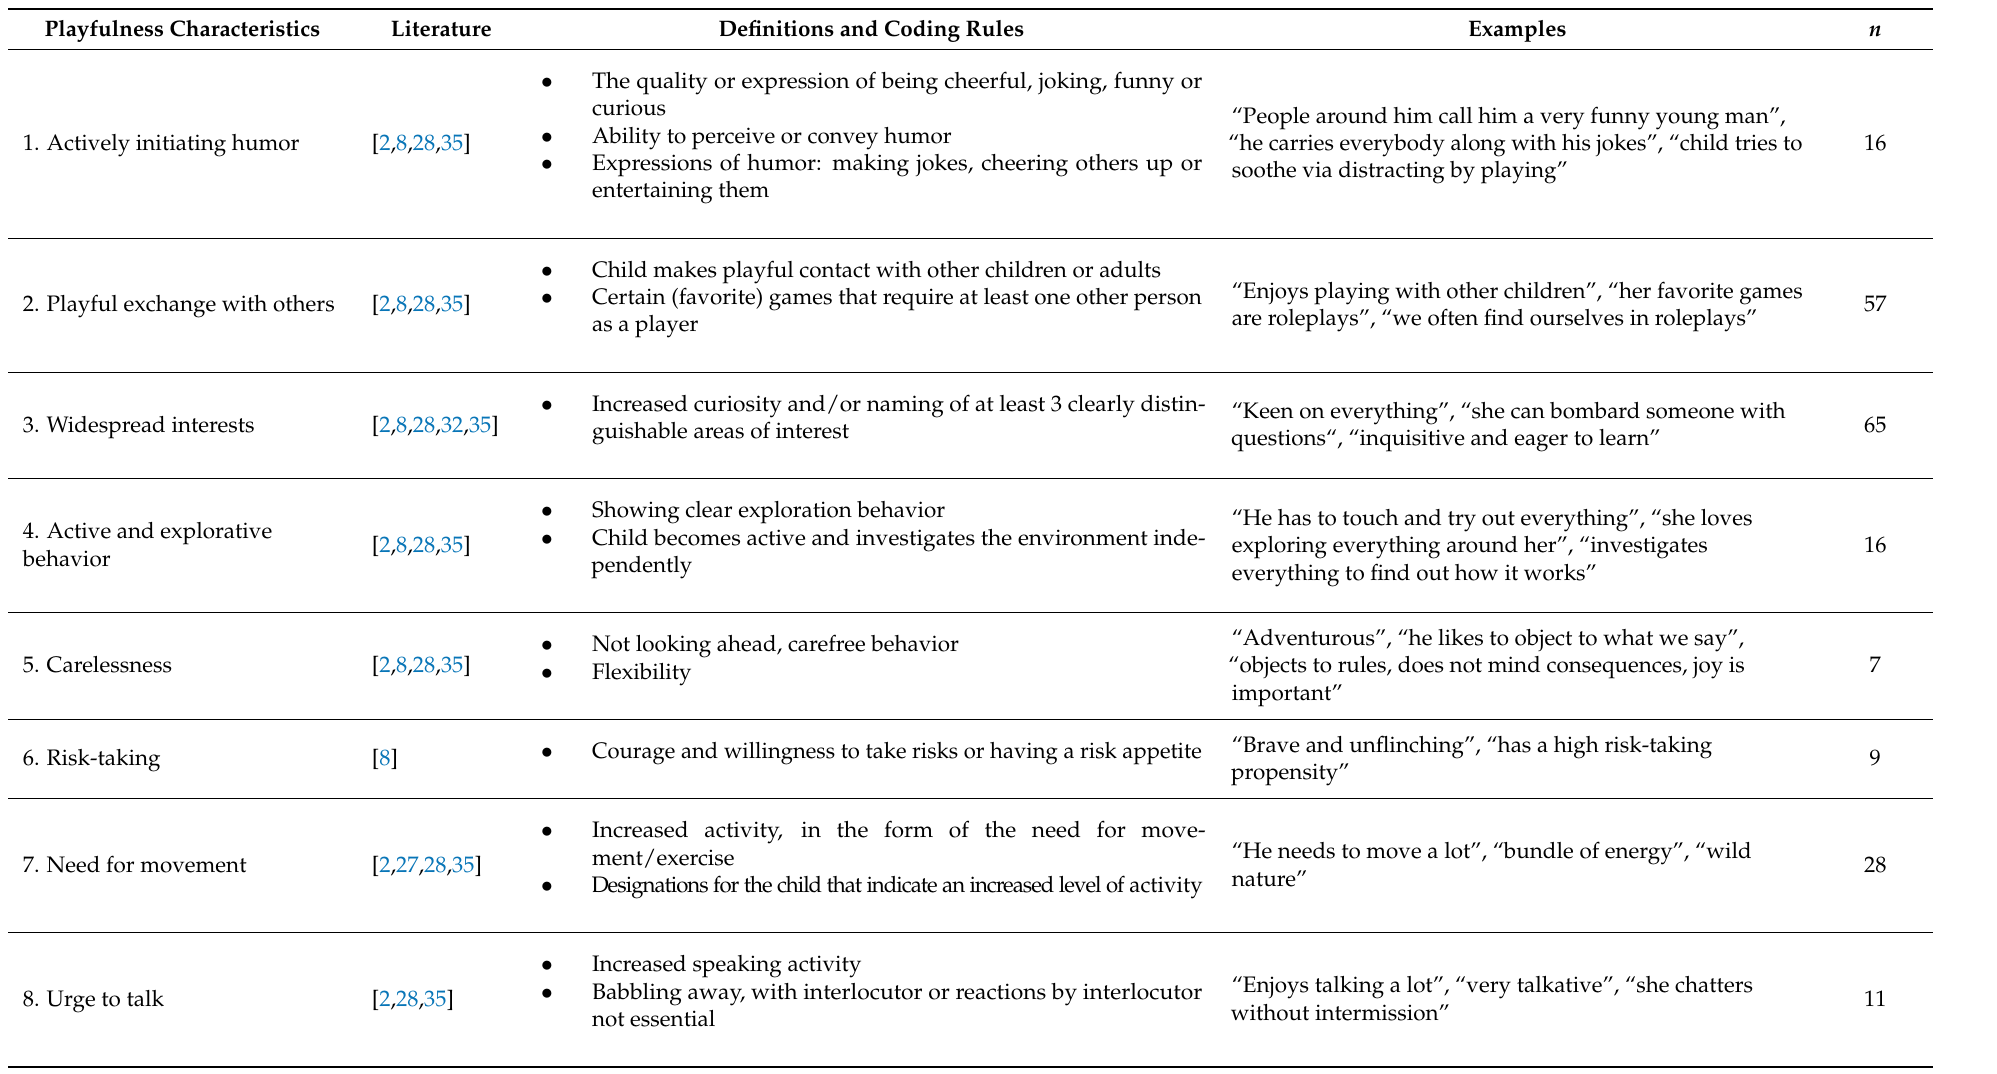
Table 1. Criteria catalog of mothers’ perception of children’s playfulness and its coding scheme, examples and mentioned numbers ( n ) for each playfulness